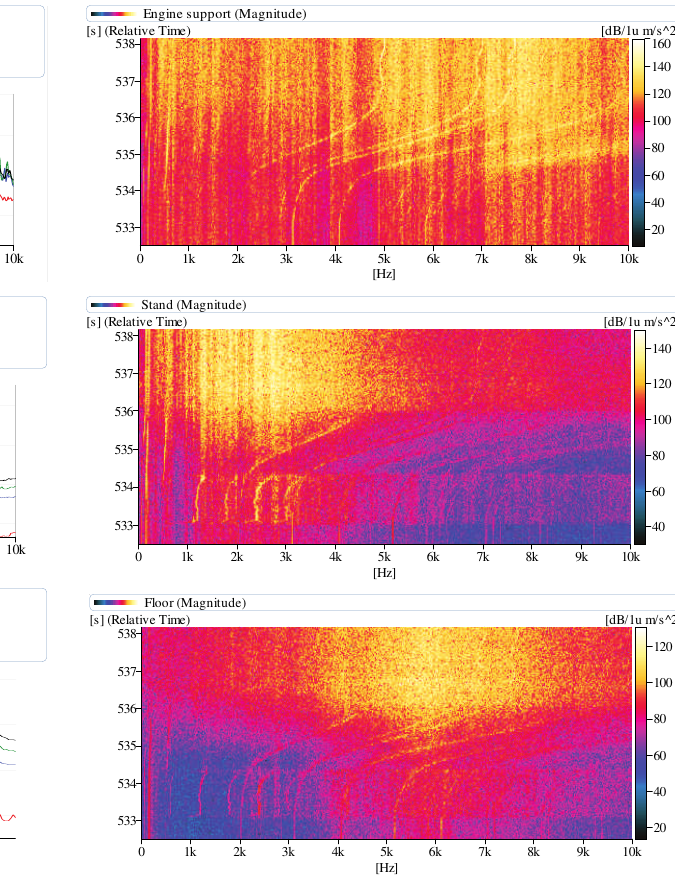
Fig. 7. Time-frequency maps of vibration signals for different measurement points From the characteristics shown in Figures 4–7, it appears that to assess the action of power in an engine tested, the best thing is to apply the point P1 or P2 because they are characterized by the better dynamics than point P3. Measurement point P1 is better than P2, for analysis concerning with natural frequencies of system. Whereas point P2 is good to frequencies analysis related